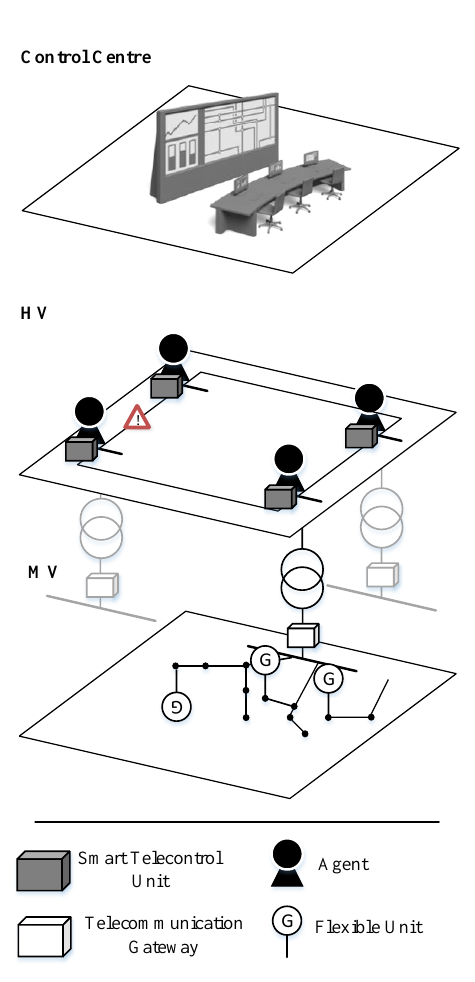
Figure 1: Overview of developed CMS